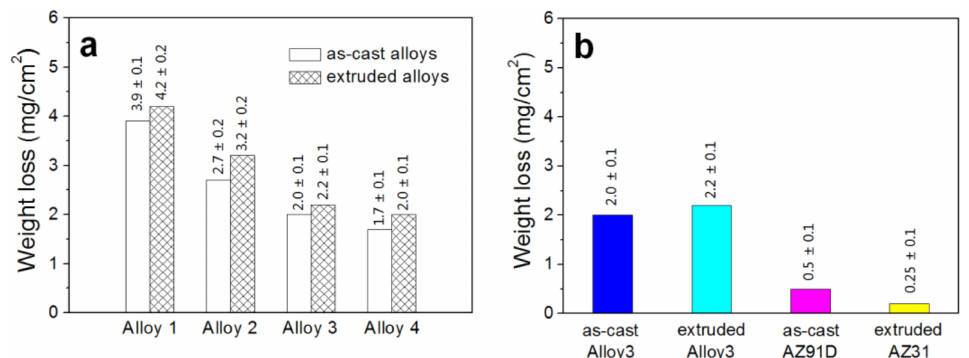
Figure 9. Weight loss of different alloys in SBF solution for 24 h: ( a ) experimental alloys; ( b ) Alloy 3 and contrast